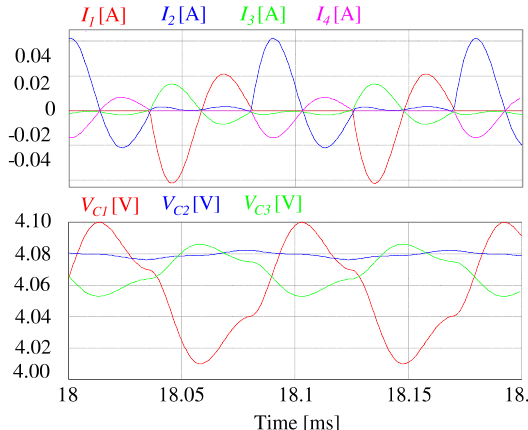
Figure 30. Zoom of the current in the cells and voltage of the capacitors in the switched capacitor–inductor network scheme.